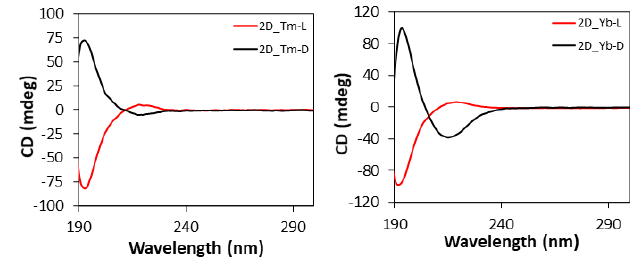
Figure 10. CD spectra of 2D compounds.